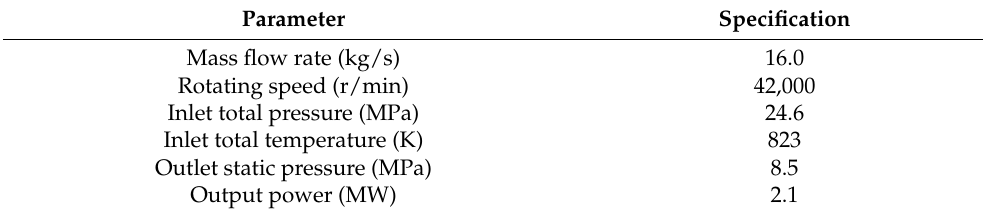
Table 3. Design specifications.